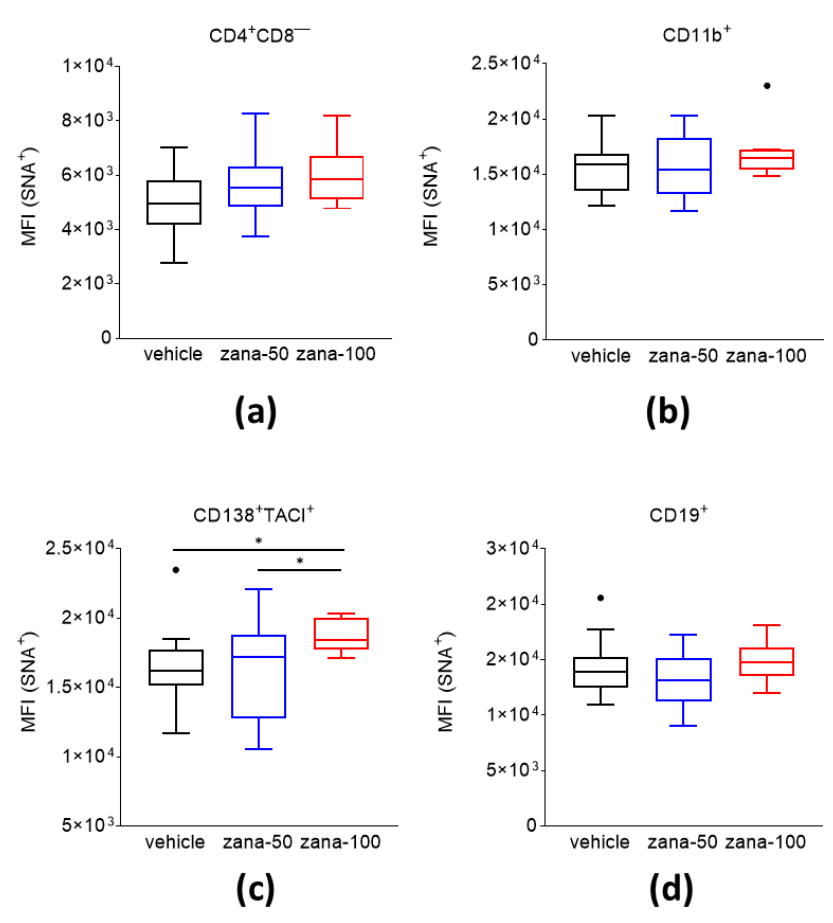
Figure 5. An increased level of alpha-(2,6)-sialic acids is observed on the cell surface of CD138 + /TACI + plasma cells after zanamivir treatment in CIA. Levels of (2,6)-SA residues on cell subsets—( a ) CD4 + CD8 − T cells, ( b ) CD11b + cells, ( c ) CD138 + /TACI + cells, and ( d ) CD19 + cells—were measured by flow cytometric analysis. Data are presented as Tukey’s box- and whisker plots. Ob- servations outside the whiskers are considered outliers and presented as black dots. * p <